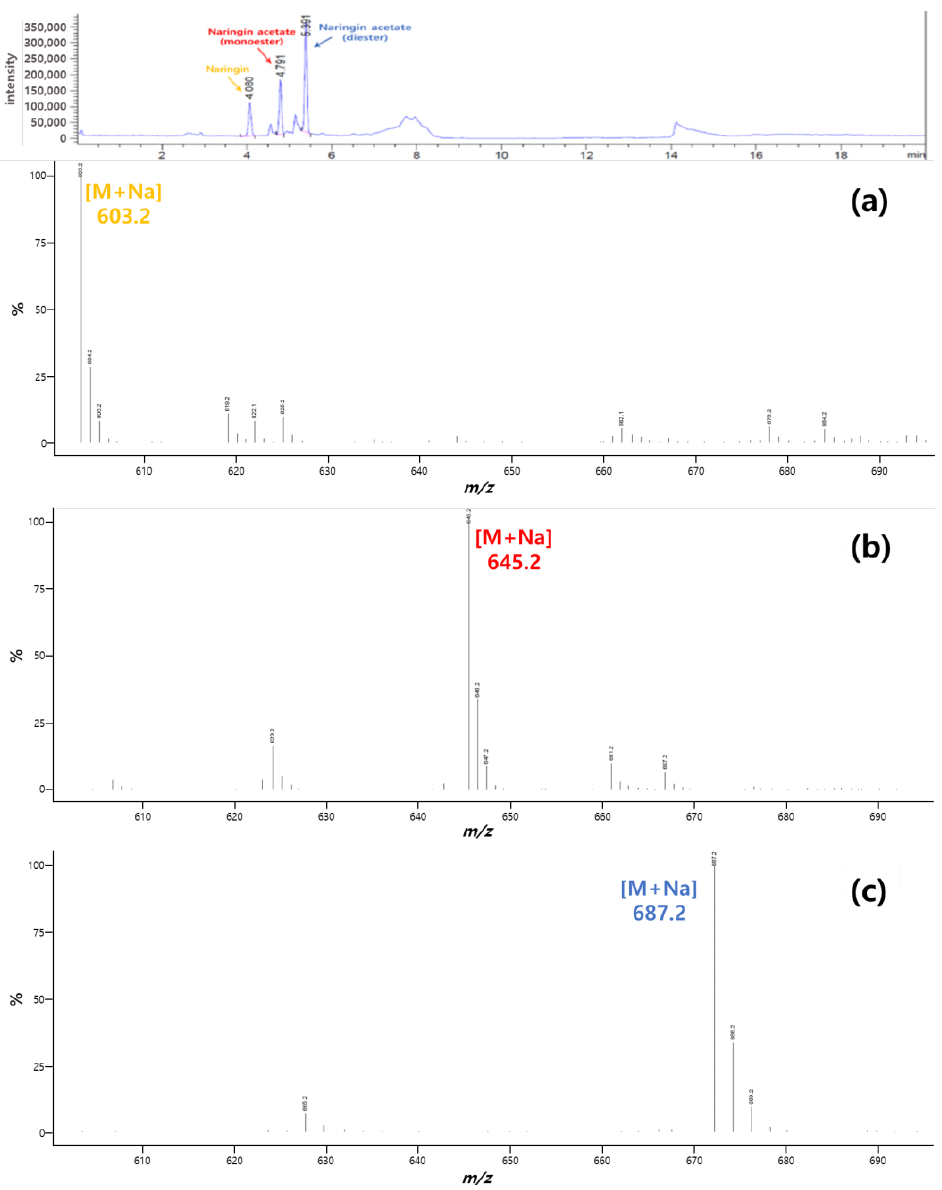
Figure 3. Results of the LC-MS analysis of naringin acetate: ( a ) naringin; ( b ) naringin acetate (monoester); ( c ) naringin acetate (diester).